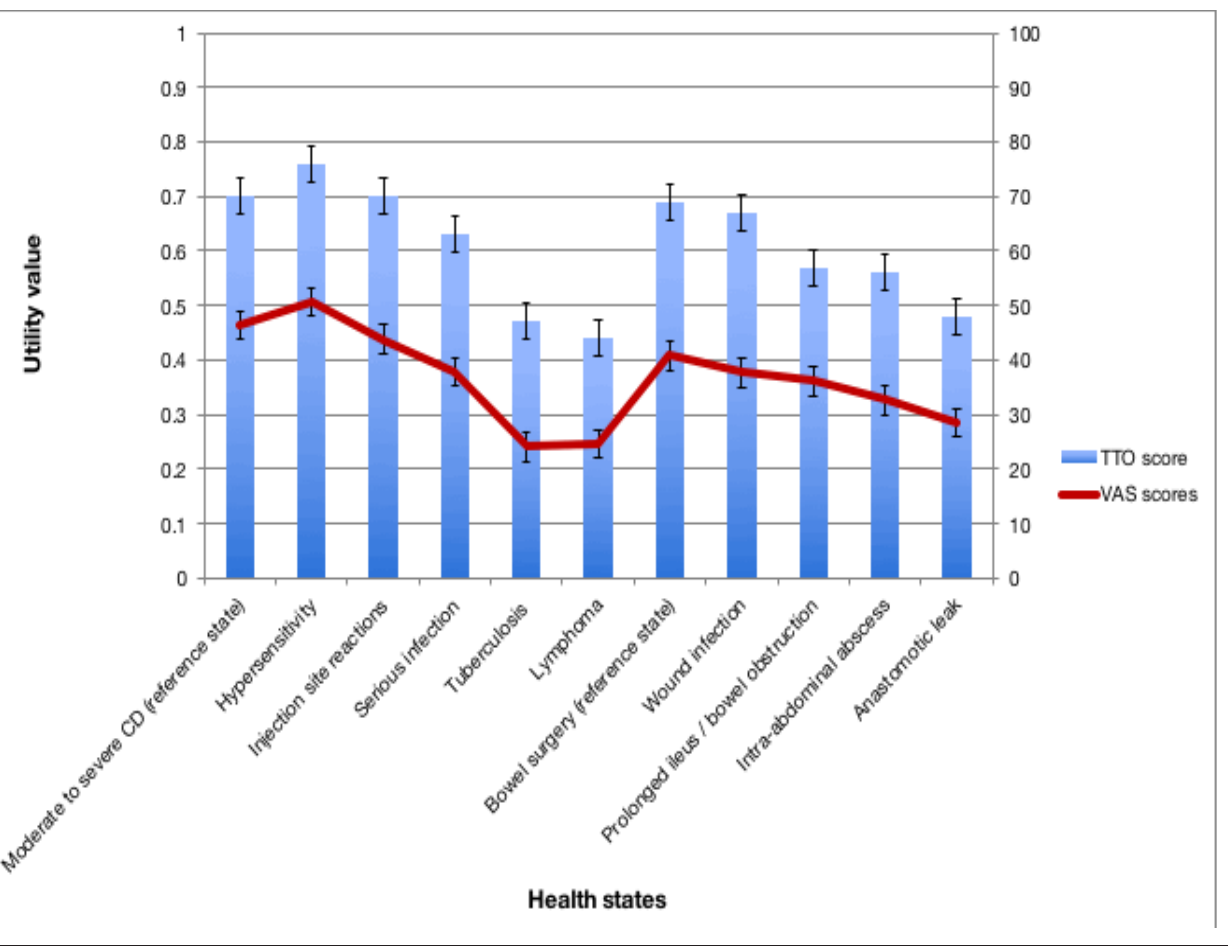
Figure 2: Mean and 95% CI TTO Utility Score (0-1) and VAS Rating (0-100) for each Health State (Best to Worst from Reference